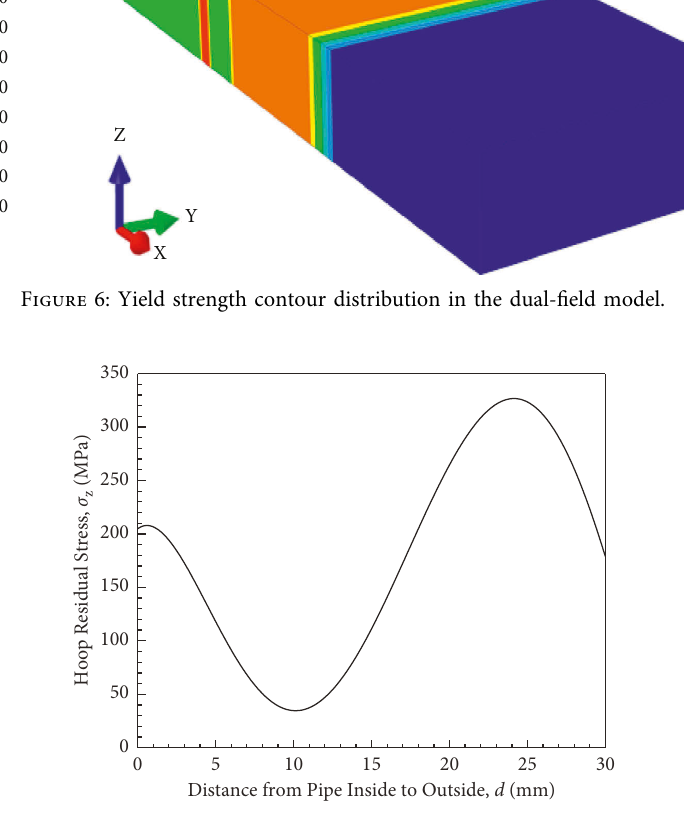
Figure 7: Hoop ( Z -direction) residual stress distribution along the Y direction of the DMWJ.